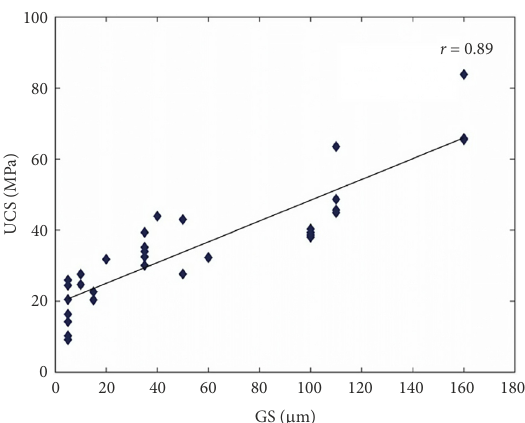
Figure 7. Uniaxial compressive strength (UCS) versus grain size (GS)